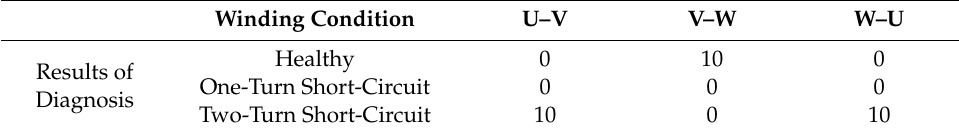
Table 5. Diagnostic results for the 1.5-kW motor 2 (two-turn short-circuit in the U phase winding).